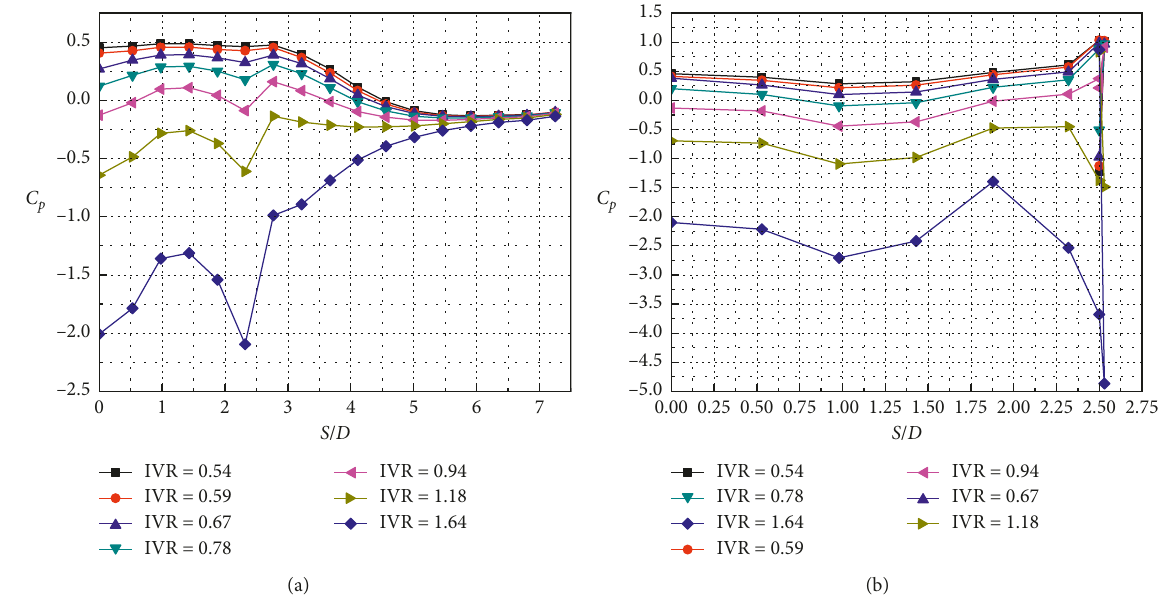
Figure 14: Pressure coefficient C p curves at the (a) upper and (b) lower walls with different IVRs.